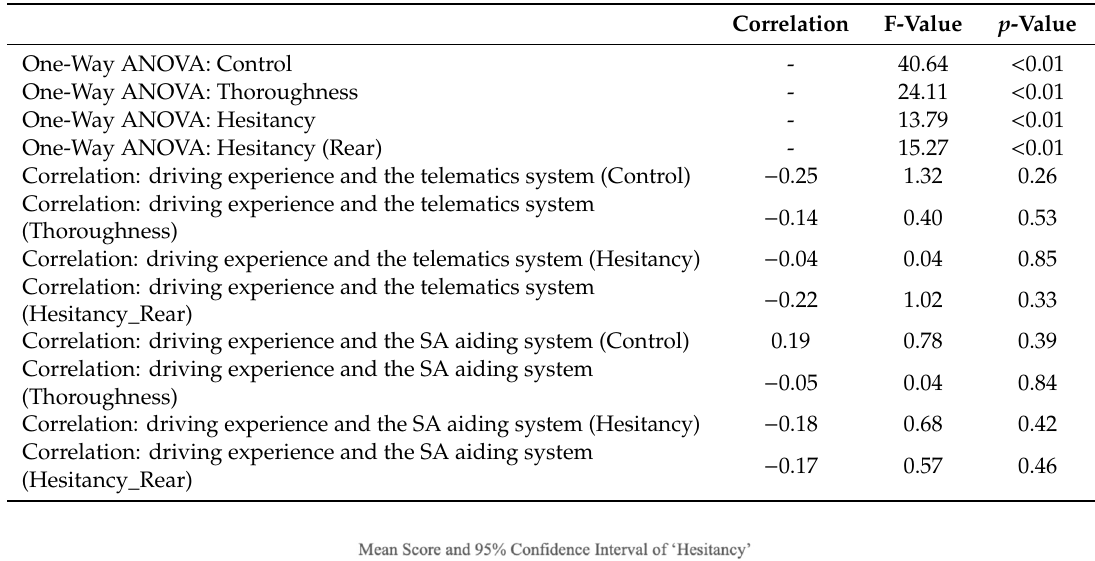
Table 4. The statistical analysis of DMQ scores: One-way ANOVA and the correlation (Source: Own creation).